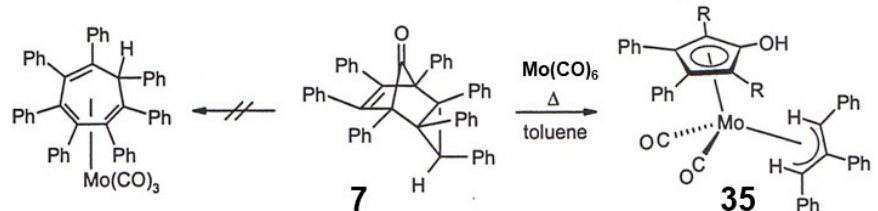
Scheme 13. Reaction of the ketone 7 with molybdenum hexacarbonyl.